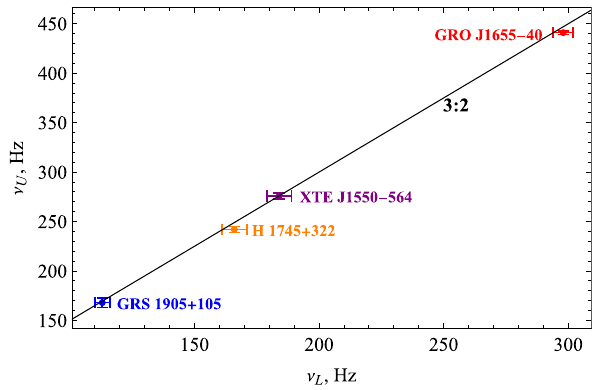
Fig. 14 LocationsoftheQPOsdetectedmicroquasarsGRS1905+105, GRO J 1655-40, H 1745+322 and XTE 1550-564 in ν U − ν L space issue. It implies that one may calculate the ISCO radius using frequency data from twin peak QPOs with a frequency ratio less than 5:4. Moreover, the QPO radius comes closer to the ISCO at higher values of the BH charge. On the other hand, it is possible to get constraints and relations between the EMS parameters and BH charge using the results of studies of QPO orbits.